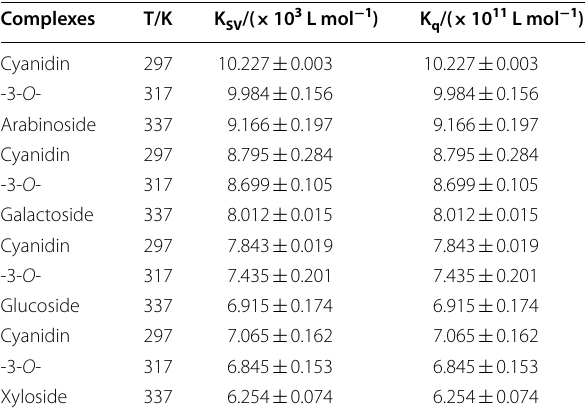
Table 1 The dynamic quenching constants of Cyanidin-3- O -arabinoside, Cyanidin-3- O -galactoside, Cyanidin-3- O - glucoside and Cyanidin-3- O -Xyloside at 297, 317 and 337 K